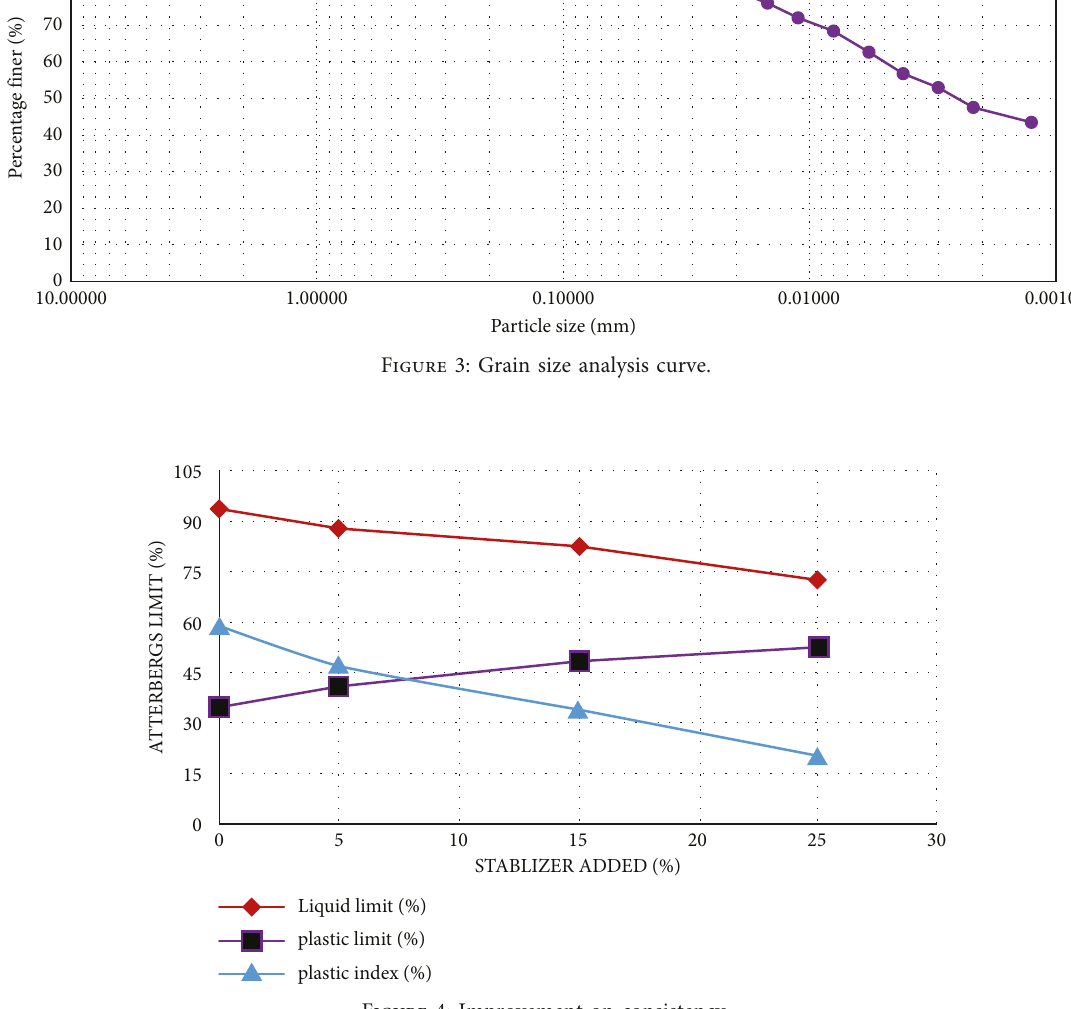
Figure 4: Improvement on consistency.